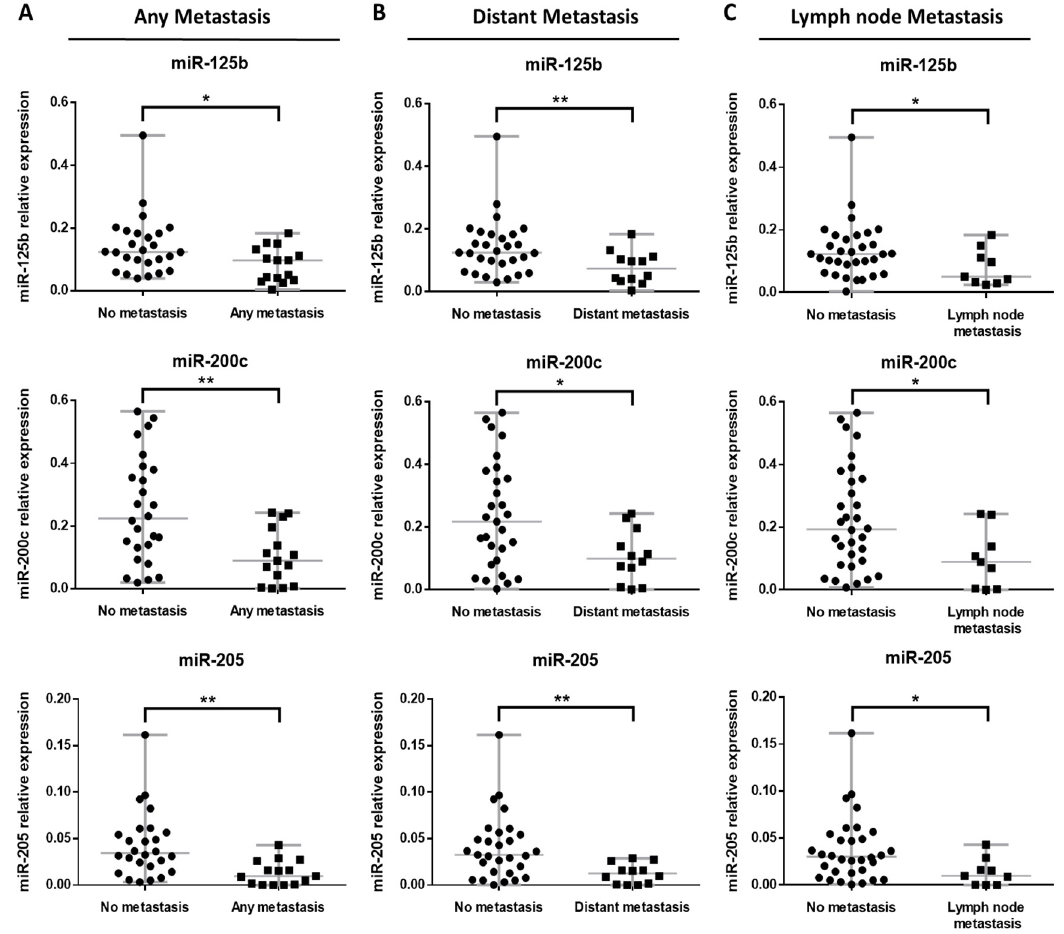
Figure 4. Relative expression of miR-125b, miR-200c and miR-205 according to the metastatic behavior of BRAF mutated primary tumors for ( A ) any metastasis, ( B ) distant metastasis and ( C ) lymph node metastasis. Significant at * p -value < 0.05, ** p -value < 0.01.